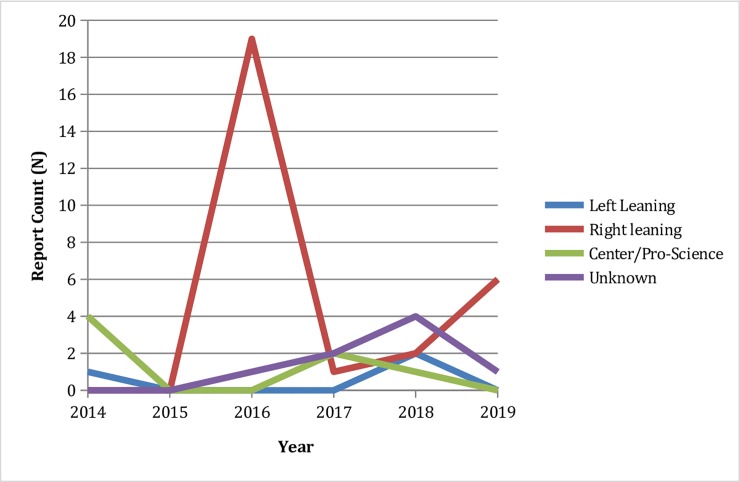
TB report count categorized by political leaning by year.